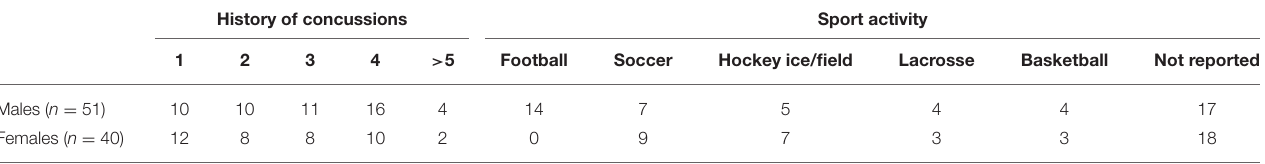
TABLE 3 | Concussion history and sport/injury activity of last concussion.